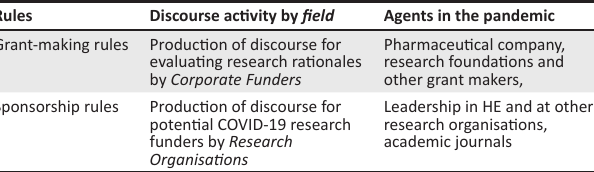
TABLE 6: Grant-making and sponsorship discourse activity and